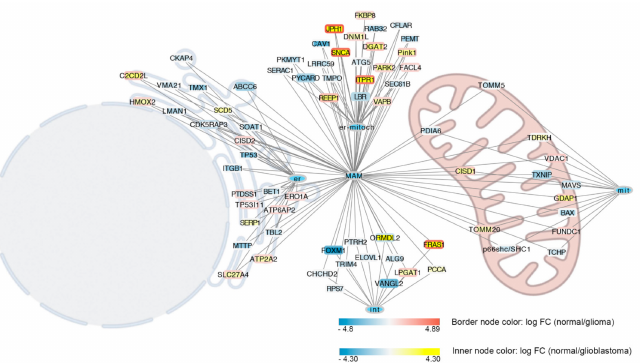
Figure 2. Differentially expressed genes involved in MERC interactions. Genes associated to MERC interactions are represented according to subcellular localization of coded proteins. Proteins specif- ically localized in the endoplasmic reticulum are associated with the node labelled as er, those associated with mitochondria are associated with the node labelled with mit, and those localized both in ER on in the mitochondria are associated with the node labelled with er–mitoch. Proteins involved in MERCs according to [104] not specifically associated with ER or mitochondria were linked to a node labelled with int. All nodes are linked to the MERCs node because all are involved in the formation of MERCs. MERCs, ER, mitochondria, and ER–mitochondria nodes are colored with light blue while other nodes are colored according to the log FC expression of control versus high grade glioblastoma. Differently node border is colored according to the log FC expression of control versus glioma. Blue indicates highly expressed in the tumor, yellow or red in the control, and white indicates